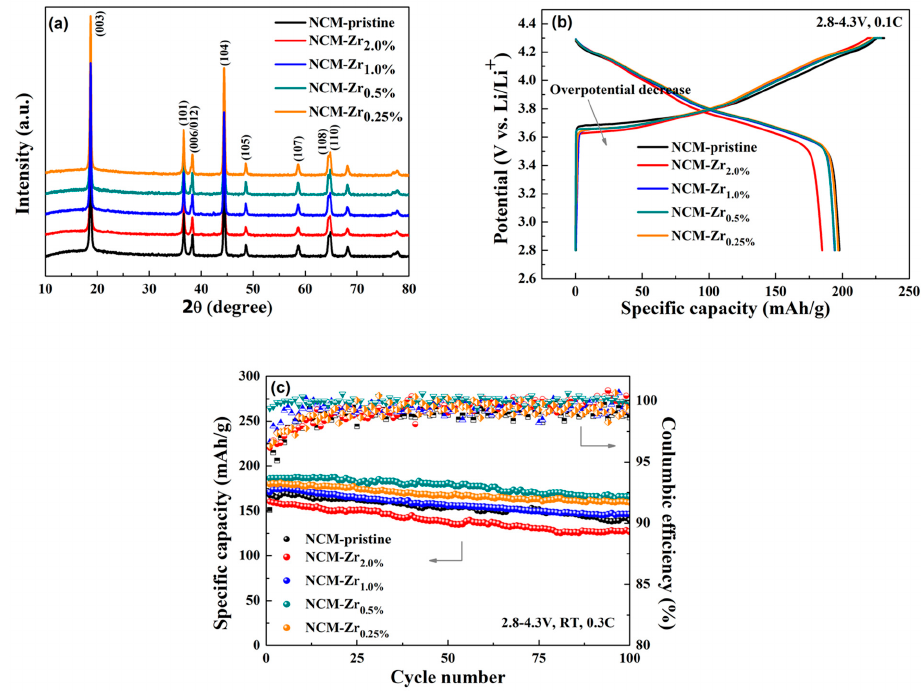
Figure 5. ( a ) XRD patterns of pristine and ZrO 2 -modified SNCM cathodes, ( b ) first cycle charge– discharge curves of pristine and ZrO 2 -modified SNCM cells at 0.1 C, and ( c ) cycling performance of ZrO 2 -modified SNCM cells at 0.3 C rate (temperature, RT; voltage window, 2.8–4.3 V).